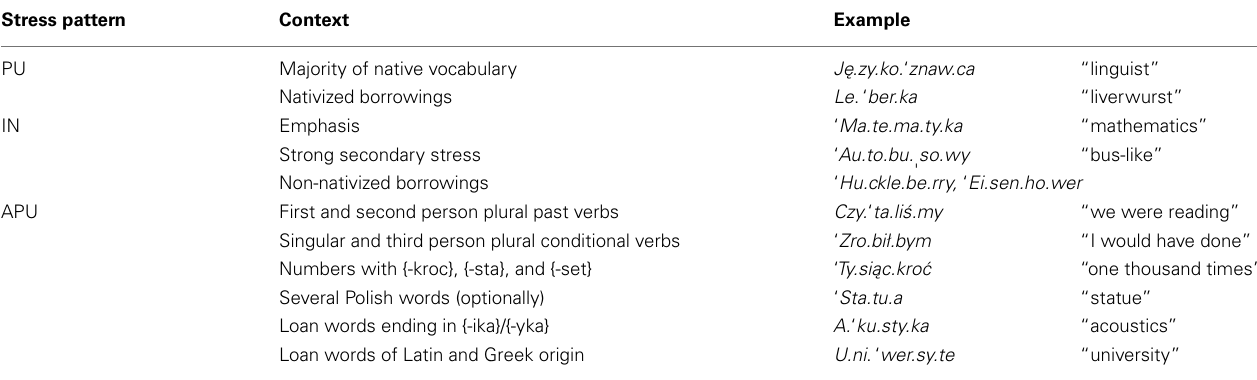
Table 1 | Overview of stress patterns in